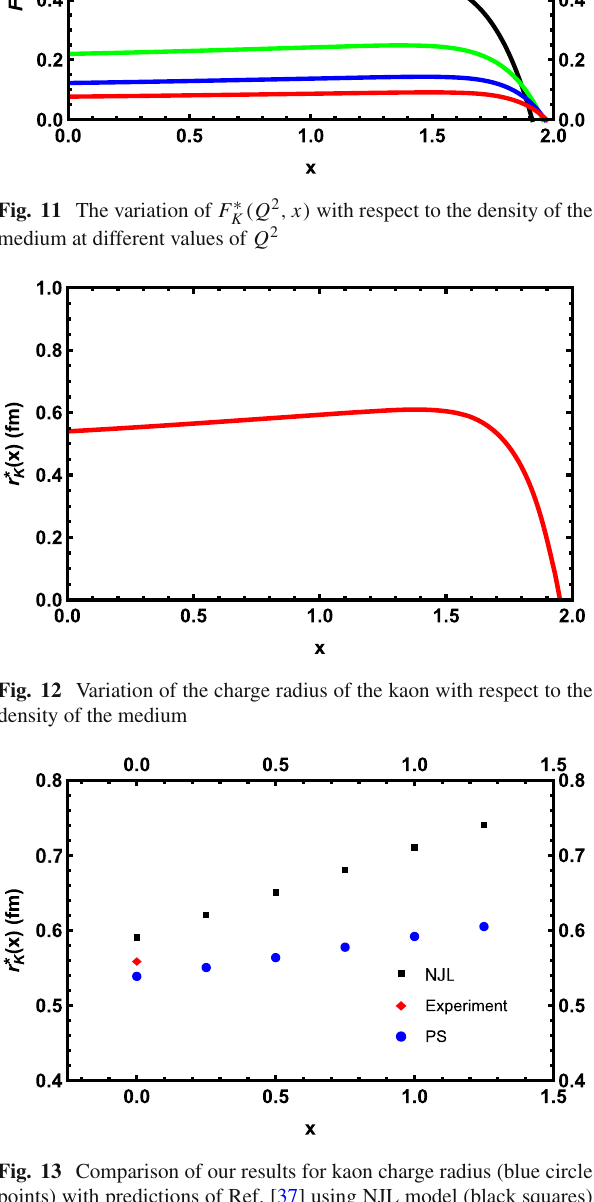
Fig. 13 Comparison of our results for kaon charge radius (blue circle points) with predictions of Ref. [37] using NJL model (black squares) at different densities. We also show the experimental result in